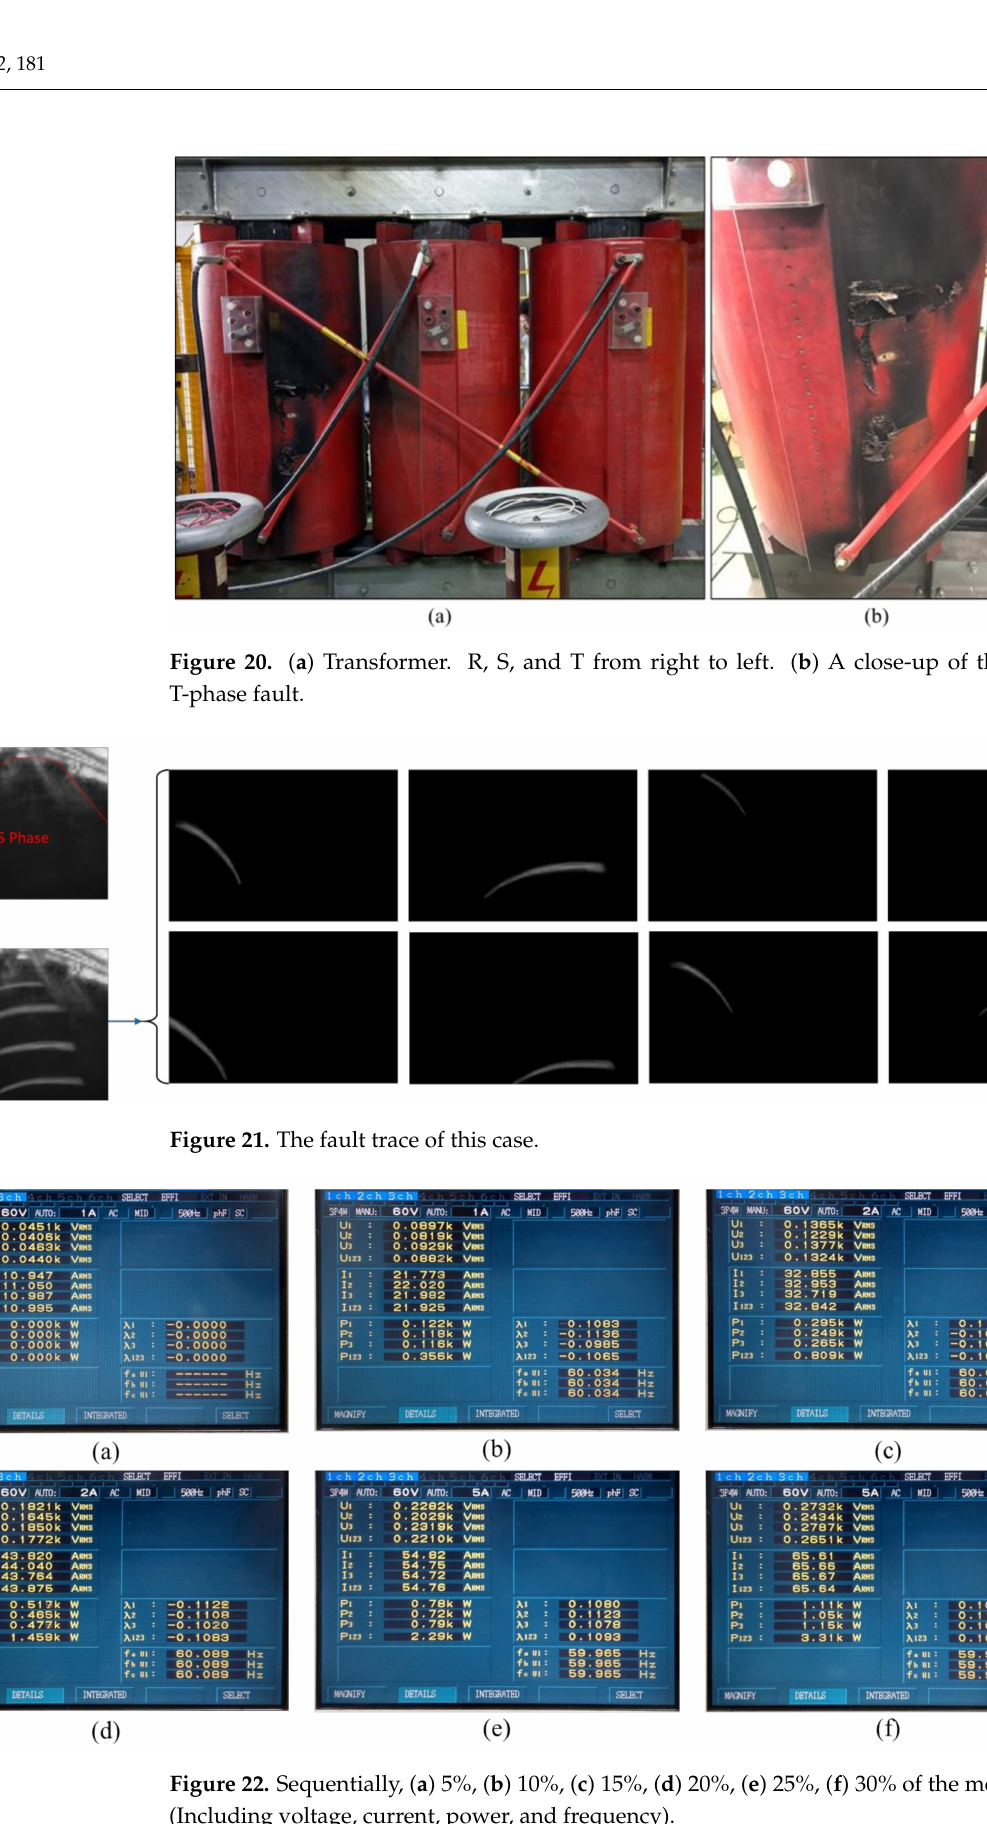
Figure 22. Sequentially, ( a ) 5%, ( b ) 10%, ( c ) 15%, ( d ) 20%, ( e ) 25%, ( f ) 30% of the measurement data. (Including voltage, current, power, and